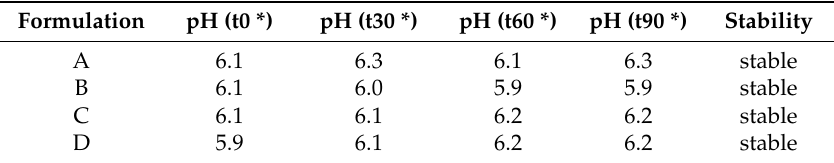
Table 2. Accelerated stability profile of Formulations A, B, C, and